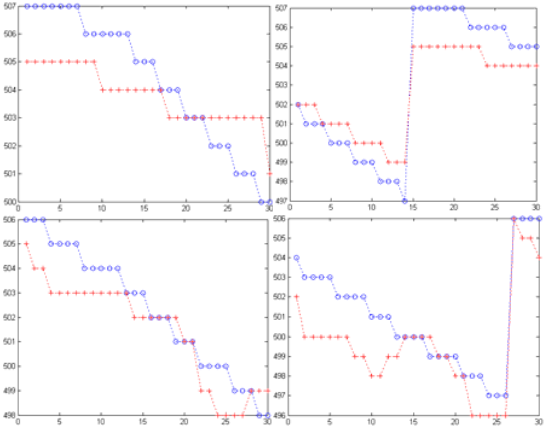
Figure 4. Profile analysis of four sections. (blue: LiDAR, red: stereo-DSM).